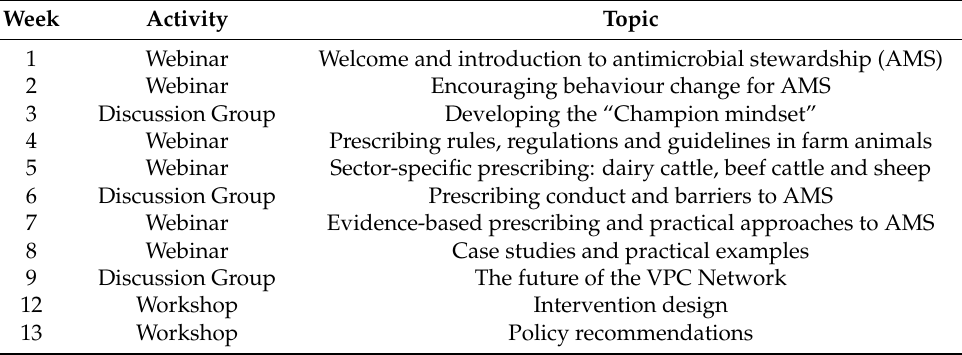
Table 3. Arwain Vet Cymru Veterinary Prescribing Champion (VPC) training schedule developed as outlined in Figure